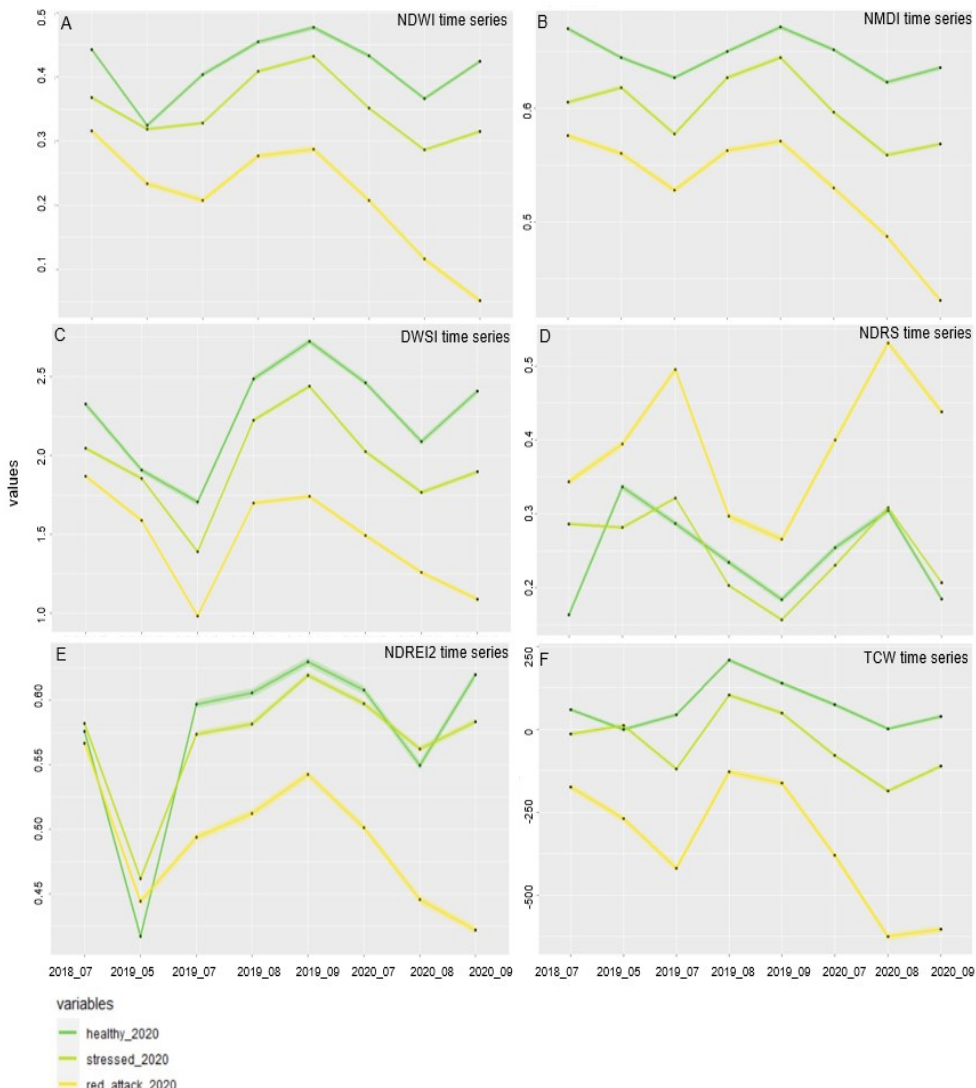
Figure 6. Mean seasonal reflectance trends (line) and standard error from 95% CI (confidence band) of vegetation indices (NDWI ( A ), NMDI ( B ), DWSI ( C ), NDRS ( D ), NDREI2 ( E ) and TCW ( F ) from 2018 to 2020 with training data from 2020 for the classes of healthy, stressed and “red_attack” stage canopies.